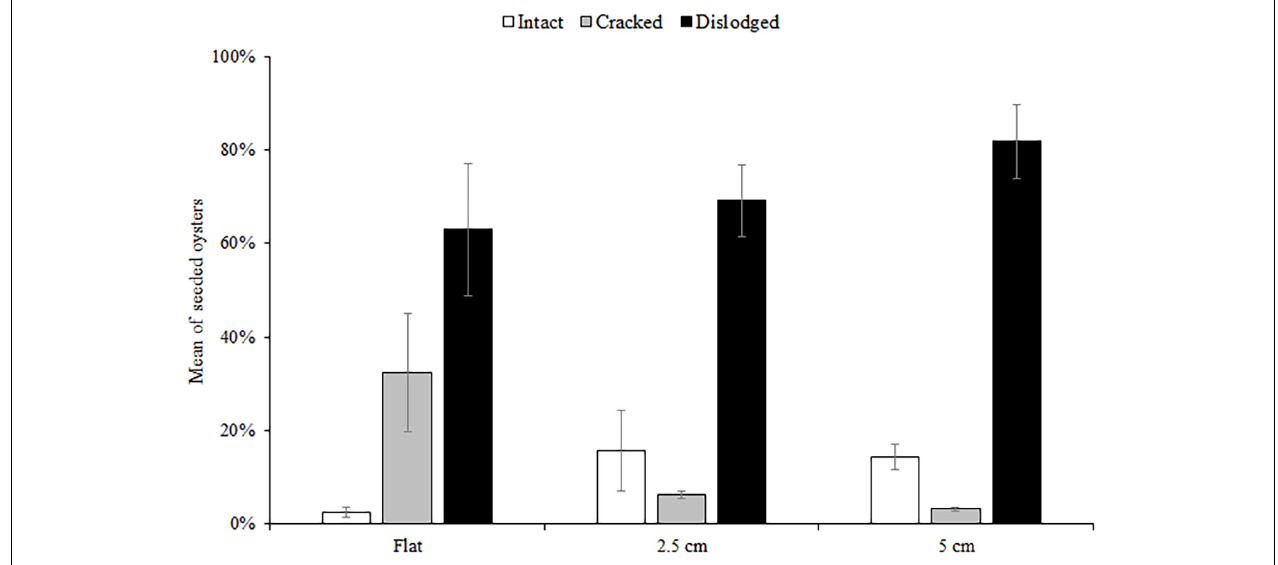
FIGURE 3 | Mean ( ± SE) percentage of dead seeded oysters recorded as intact, cracked, or dislodged from seeded flat, 2.5 and 5 cm tiles deployed at both sites. Data were pooled over the five surveys (1, 3, 6, 9, and 12 months). TABLE 3 | Summary of generalised linear mixed model on the effects of physical complexity (flat, 2.5 cm, 5 cm, control) and the number of live seeded bivalves on the taxa richness, Shannon’s diversity, and abundance (total percentage of live cover) of colonising sessile organisms through time, with site as random factor.